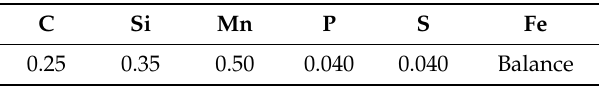
Table 1. Chemical composition of tested pipeline steel (wt %).